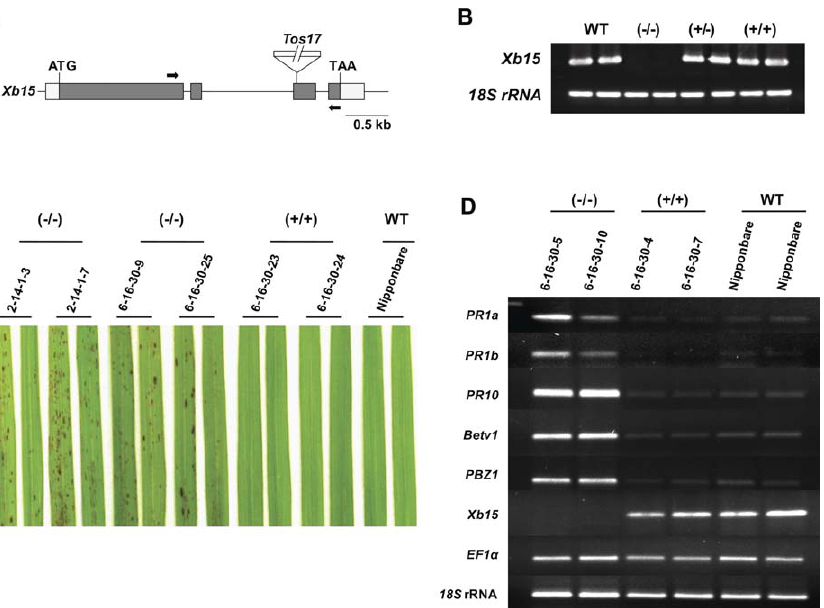
Figure 5. An Xb15 Tos17 Mutant Exhibits Cell Death Lesions (A) Representation of Xb15 genomic DNA structure and the position of the Tos17 insertion site. Four exons (boxes) are separated by three introns (lines). The protein-coding regions are indicated by shaded boxes with the start codon (ATG) and stop codon (TAA). Gray boxes correspond to untranslated sequences. Arrows indicate locations of primers designed for RT-PCR. (B) The transcripts levels of Xb15 in Nipponbare wild type (WT), homozygous Tos17 insertion ( (cid:2) / (cid:2) ), heterozygote ( (cid:2) / þ ), no-insertion plants ( þ / þ ). Total RNA was extracted from fully extended 5-wk-old leaves. RT-PCR analysis was performed with Xb15 specific primers indicated in (A). 18S rRNA was used for an internal control. (C) Morphological phenotype of the Tos17 insertional line (M 5 ) of Xb15 . Photographs were taken 6 wk after germination. Symbols for genotypes for Tos17 in Xb15 are as described above. (D) PR gene expressions in plants Xb15 Tos17 mutants (M 5 ). Total RNA was extracted from 5-wk-old wild type and insertion mutant line plants, and RT- PCR was performed with specific primers for PR1a , PR1b , PR10 , major birch allergen ( Betv1 ), and PBZ1 . Control RT-PCR reactions were carried out with EF1 a and 18S rRNA. Symbols for genotypes for Tos17 in Xb15 are same as described above.